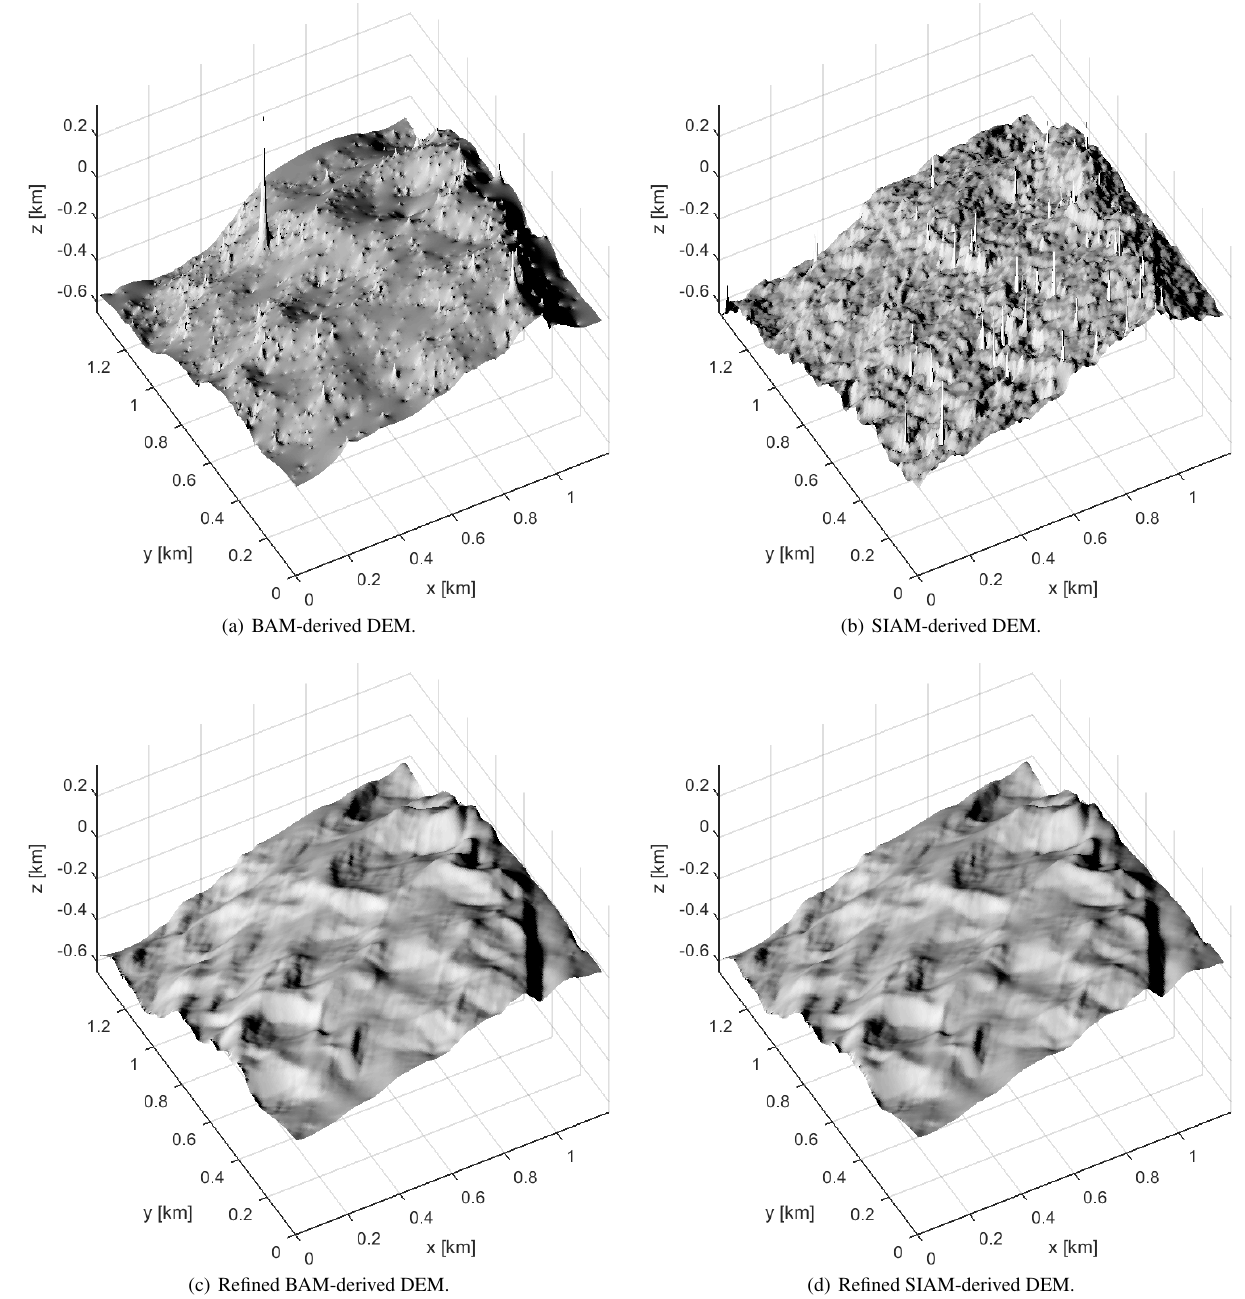
Figure 3: 3D surface plots of the DEMs. Notably, the overlying images are shaded versions of the DEM and thus represent the details of the DEM data. (a) DEM obtained using BAM. (b) DEM obtained using SIAM. (c) SfS result using the BAM-derived DEM. (d) SfS result using the SIAM-derived